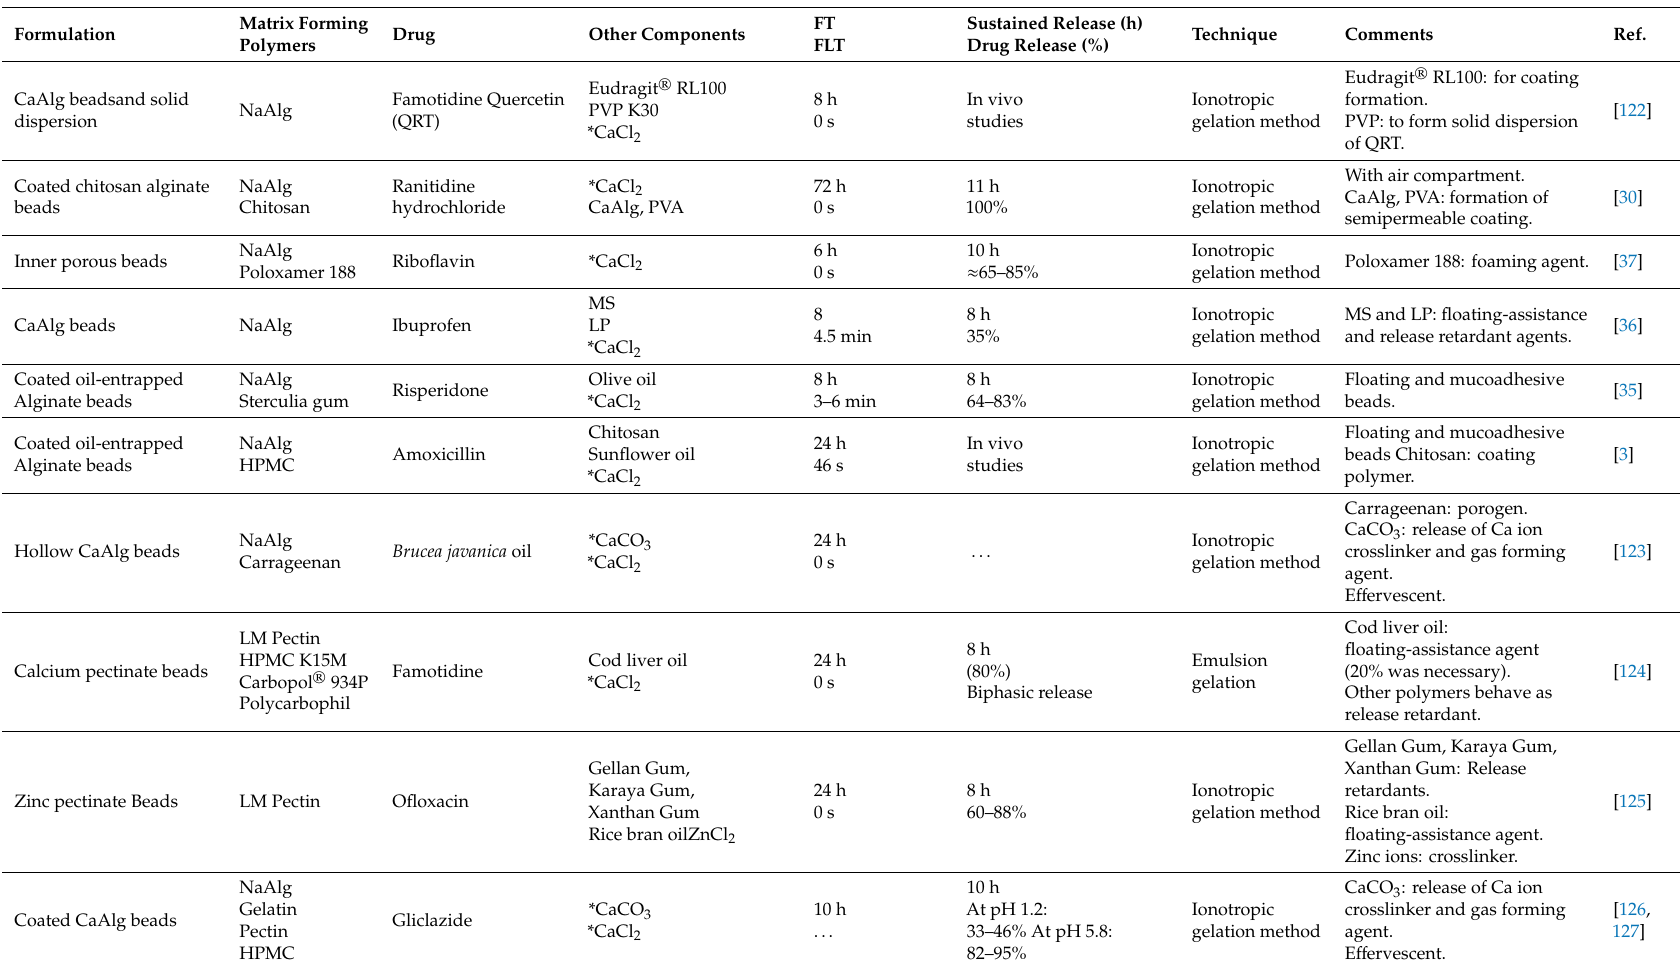
Table 7. Selected examples of multi-unit low-density